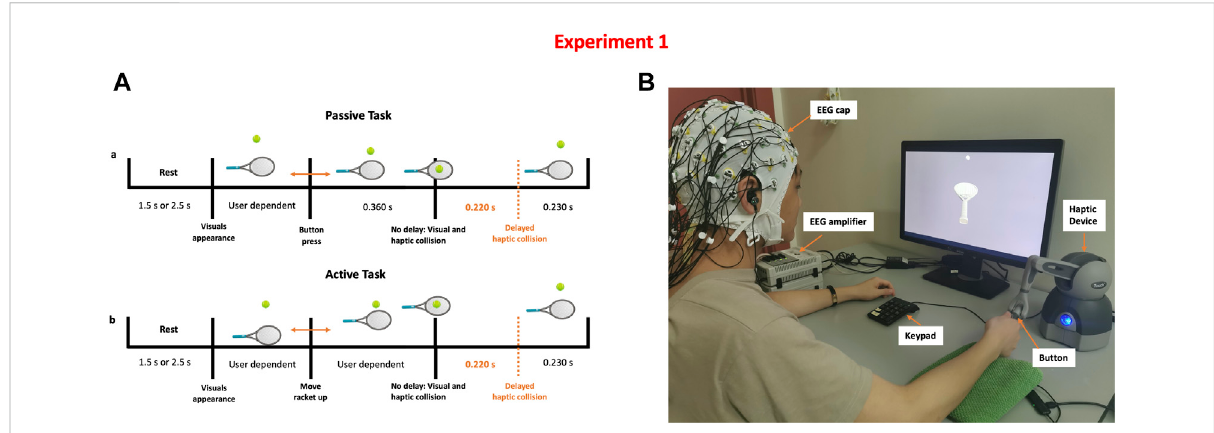
FIGURE 1 Detecting the presence of haptic delay experiment (A) Task time-line of a single trial under the passive and active haptic interactions (B) Experimental setup showing a participant correctly holding the stylus to control the racket shown on the screen. Synchronous and delayed haptic feedback are delivered through the